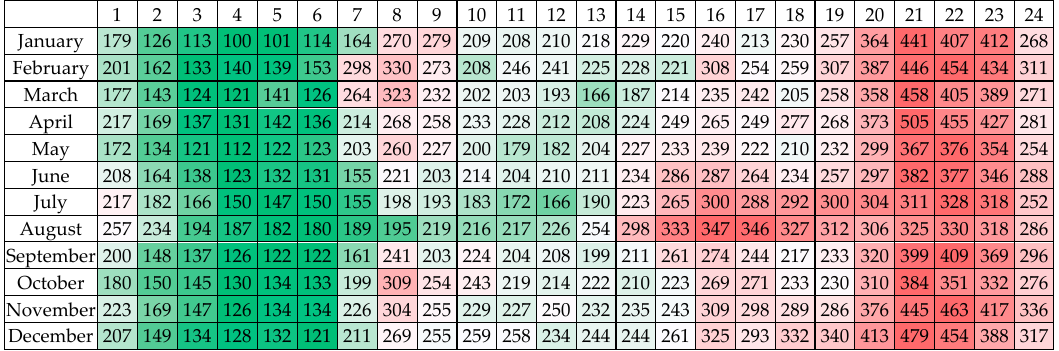
Figure 10. The aggregate profile of average power: weekdays. (Green: low; White: medium; Red: high).